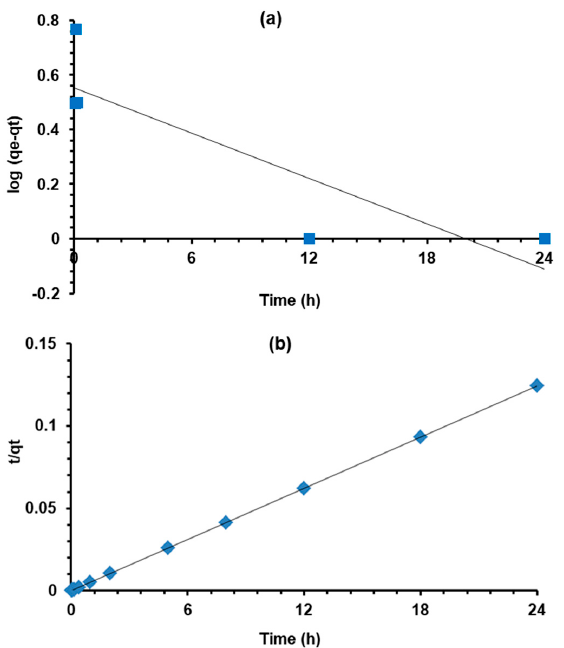
Figure 3. Kinetic modeling with ( a ) pseudo-first order (PFO) and ( b ) pseudo-second order (PSO) data for Cr(VI) adsorption onto rice husk. Table 1. Parameters of kinetic modeling for Cr(VI) elimination by rice husk. Pseudo ‐ First Order